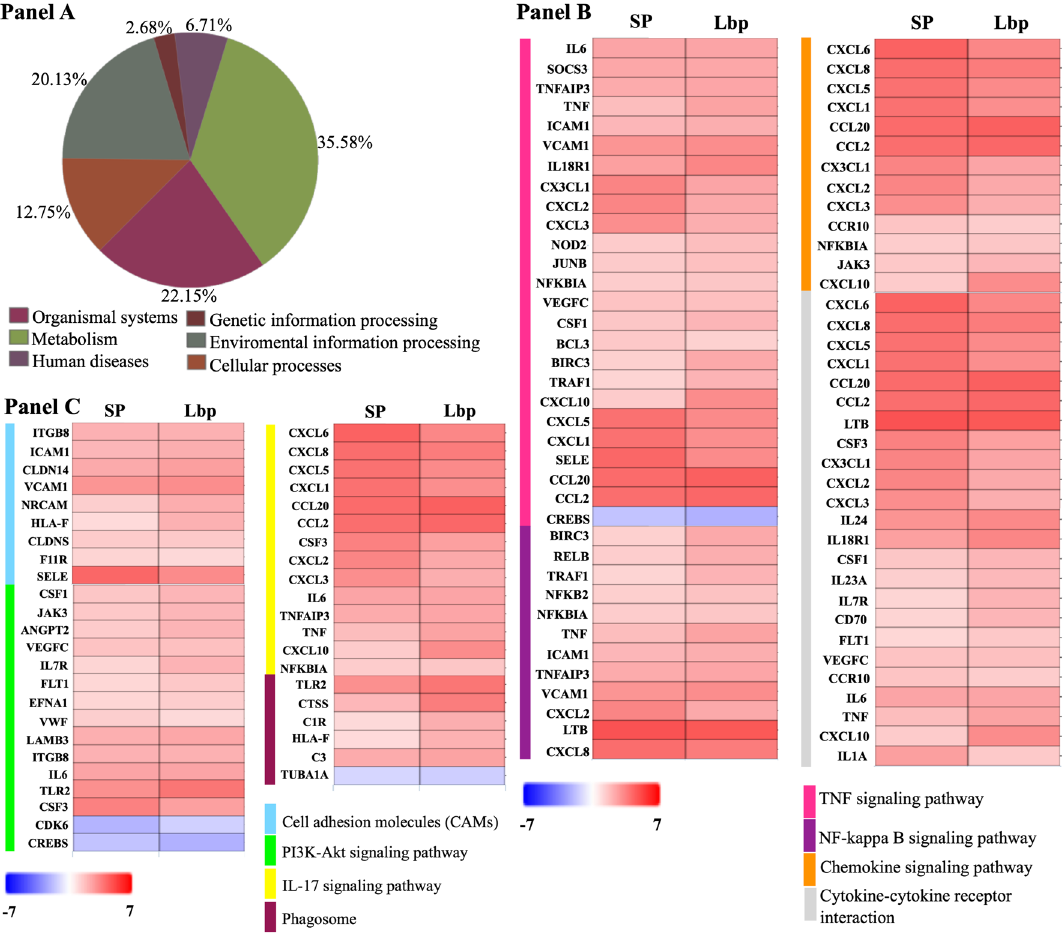
Figure 3. Functional analysis of DEGs identified in the S. pneumoniae -induced and Lbp-induced hBMECs transcriptome. (Panel A ) represents Gene ontology molecular functions investigated with PaintOmics server. Pie chart representing functional categories automatically generated from DEGs induced in both treatments of hBMECs ( S. pneumoniae or Lbp). (Panel B , C ) show the integrative analysis of signaling pathways/GO biological processes. Heat maps showing statistically significant biological processes involved in the immune response identified by PaintOmics server. Red shaded genes—up-regulated, blue shaded genes—down-regulated. Shading intensity indicates the expression degree that each gene experienced. White color indicates no significant change in the gene expression. Range of the fold change (LogFC values) are presented in the scale. Color bars indicate biological processes. TNF signaling pathway, NF-kappa B signaling pathway, Chemokine signaling pathway and Cytokine-cytokine receptor interaction activated by S. pneumoniae (SP) and Lbp in hBMECs are displayed in ( B ). Cell adhesion molecules, PI3K-Akt signaling pathway, IL-17 signaling pathway, Phagosome) activated by S. pneumoniae (SP) and Lbp in hBMECs are shown in (Panel C